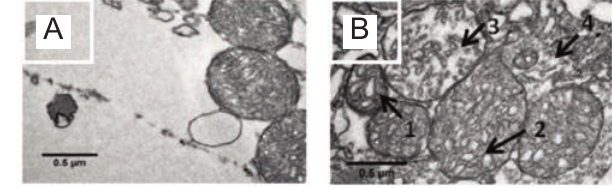
(P<0.05).Figure 3. Ultrastructure of muscular mitochondria in roach exposed to 50 µg.L –1 after one day of ethofumesate exposure at 10°C. A) Electron micrograph from control roach muscle show- ing round regular mitochondria. B) Electron micrograph from contaminated roach muscle showing disrupted outer mitochon- drial membrane (1), dilated cristae (2), destroyed cristae and absent matrix (3), and mitochondria entirely destroyed